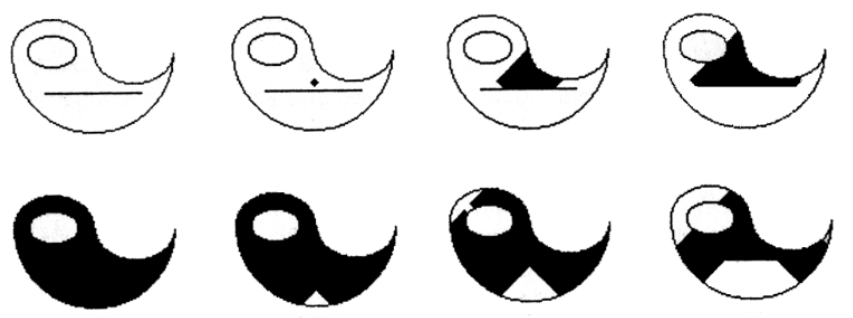
Figure 12. Wave algorithm.